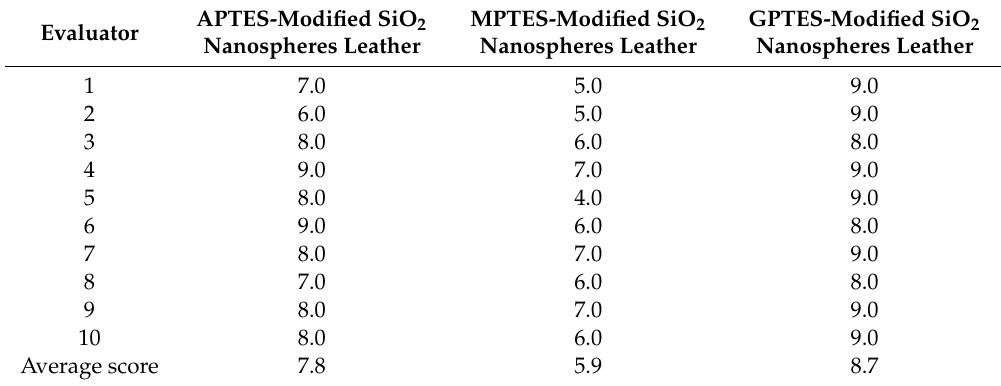
Table 3. Sensory evaluation of leather absorbing the modified SiO 2